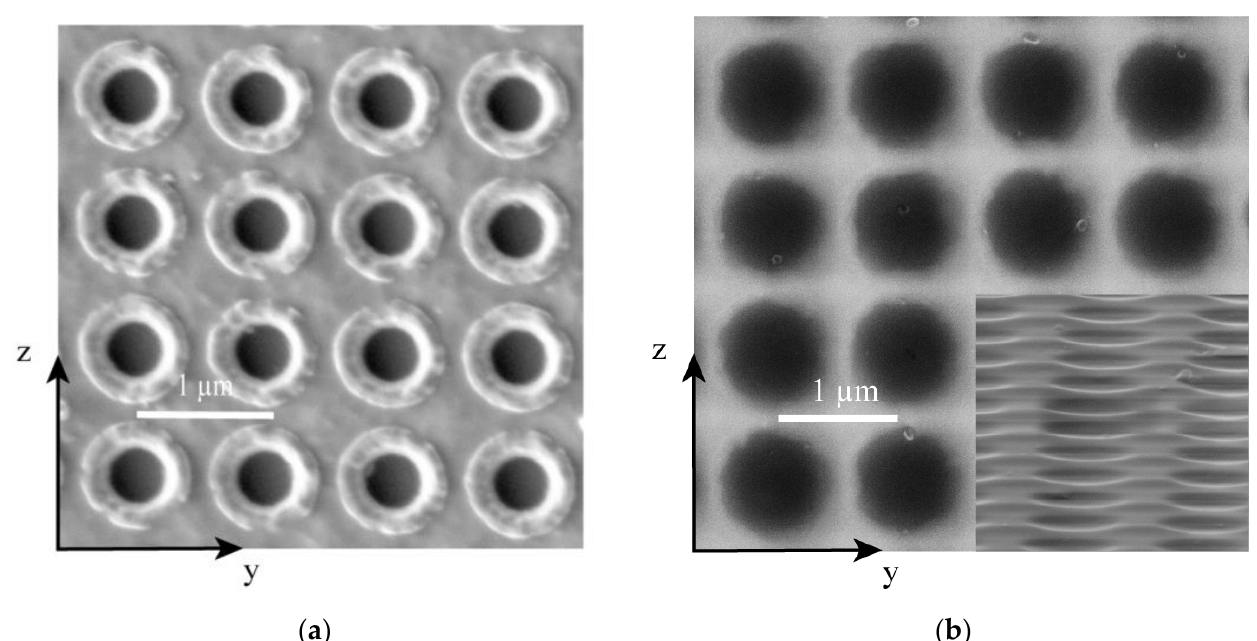
Figure 3. Scanning electron micrograph (SEM) images of the fabricated LN metasurfaces along the yz plane. ( a ) The top-view SEM image of the fabricated LN metasurface after ICP etching and before KOH wet etching; ( b ) The top-view SEM image of the fabricated LN metasurface after KOH wet etching; the inset is the tilt-10° view image.